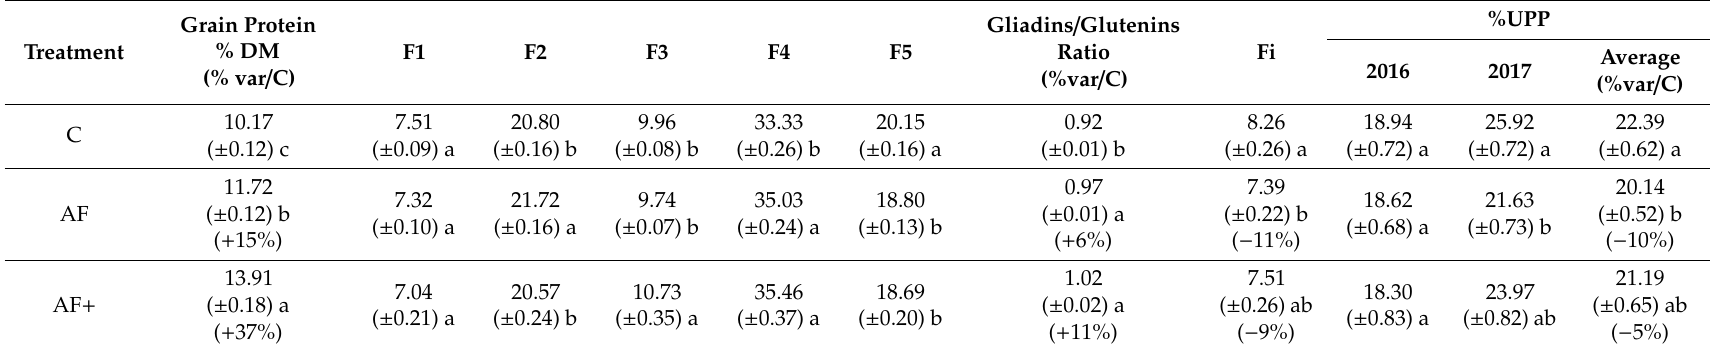
All data, except for %UPP (whose values were significantly di ff erent between the two years) were calculated as an average over the 2016 and 2017 data ( ± SE). In a column, means with di ff erent letters were significantly di ff erent according to Tukey’s HSD test. The average grain protein, gliadin / glutenin ratio, Fi, and %UPP are also expressed as a percentage variation compared with the C